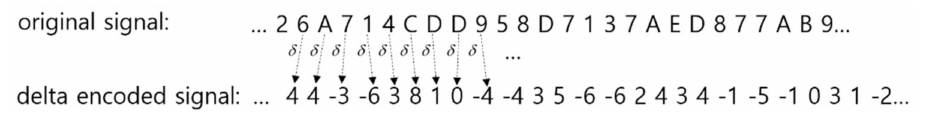
Figure 3. Concept of delta encoding. Amplitude changes between sampling intervals are the result of encoding.